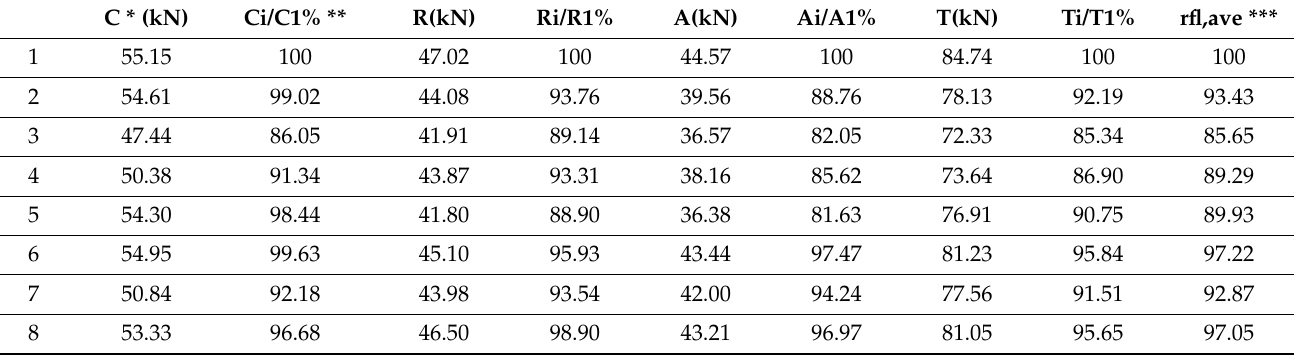
Table 4. Defective-model failure load to intact-model failure load ratios and failure loads of all